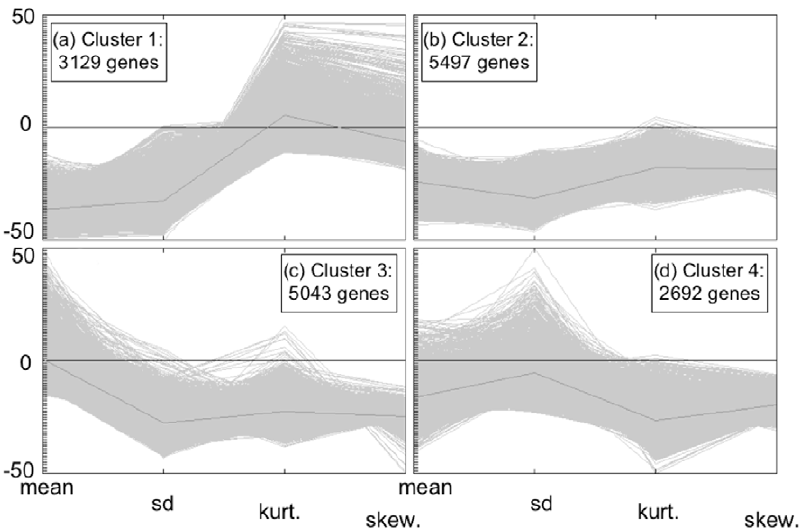
Figure 4. GEP metrics for each gene clustered into one of four clusters. Gene categories: (a) predominantly-off, (b) graded, (c) predominantly-on, and (d) switch-like genes.